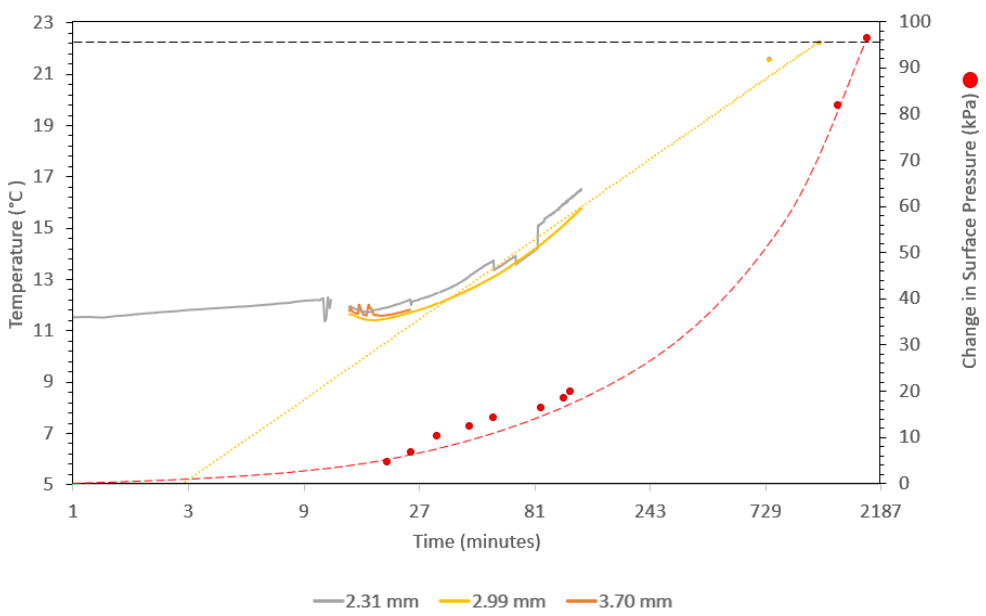
Figure 11. Full processing test results; left axis temperature of the embedded thermocouples (grey, orange, and yellow), yellow dashed line is the trend line of the thermocouple readings, the dashed black line is the external air temperature, and the right axis displays surface pressure between the rubber and aluminum clamshell mold, time is displayed in log base 3.